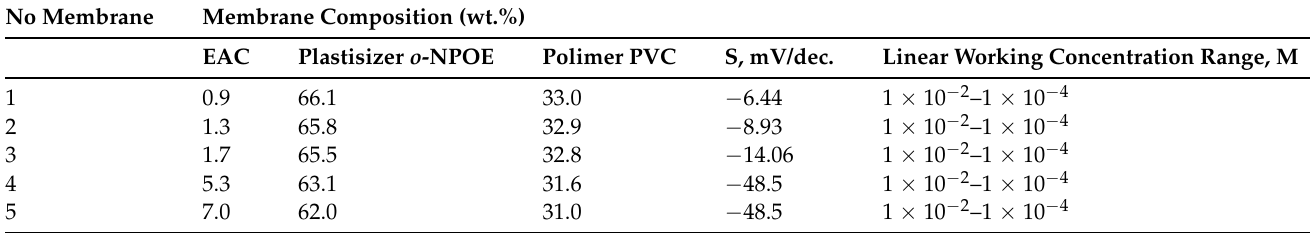
Table 1. Composition of MT-SE membranes based on ODAH + MT – . No Membrane Membrane Composition